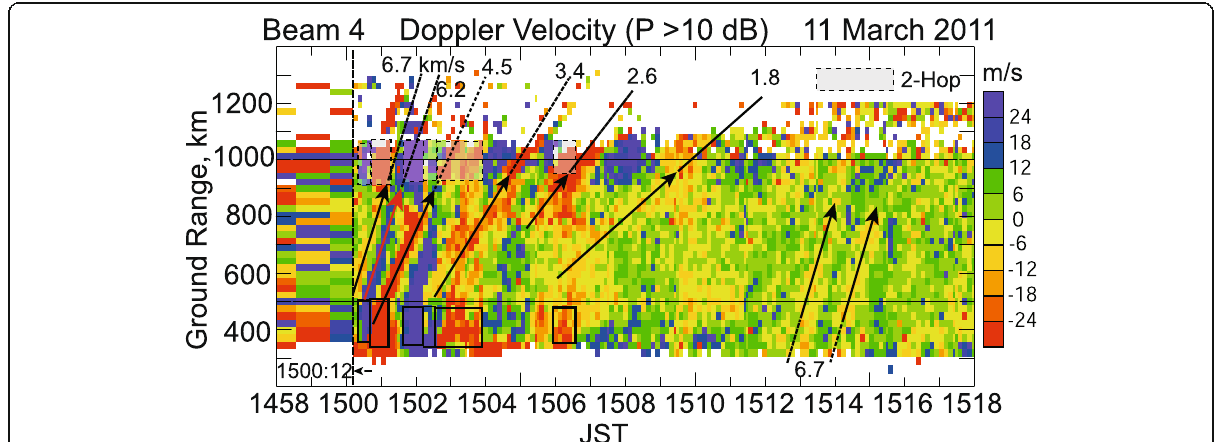
Fig. 31 Doppler velocity of HOK echoes on beam 4 (echo power > 10 dB) versus Japanese Standard Time (JST) after an earthquake on 11 March 2011. Sloped lines mark several individual echo bands propagating northward away from the earthquake epicenter. Measurements at 900 – 1100 km range (dashed rectangles) are 2-hop signals while their 1-hop counterparts are identified by solid rectangles at 350 – 500 km range. Adapted from Fig. 5 of Ogawa et al.